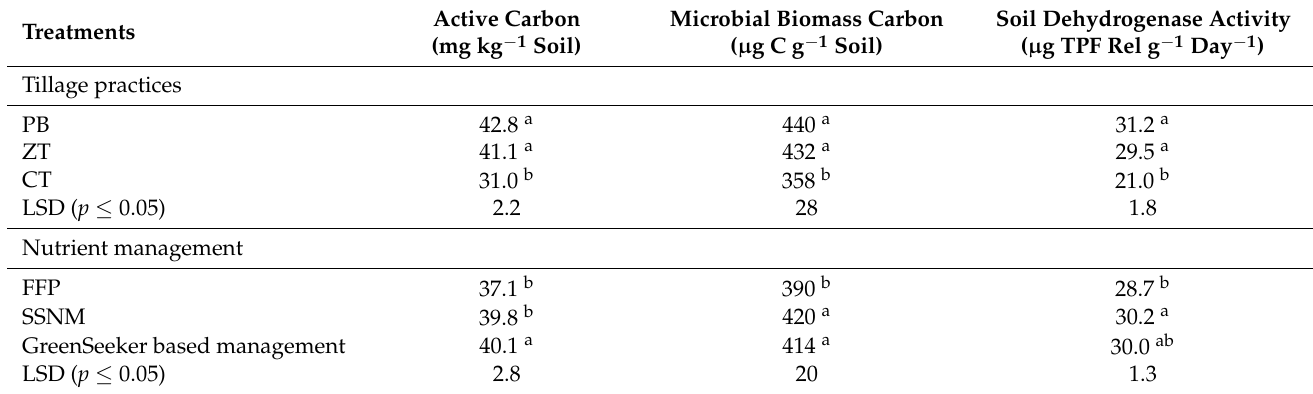
Table 3. Soil biological properties under different tillage and nutrient management